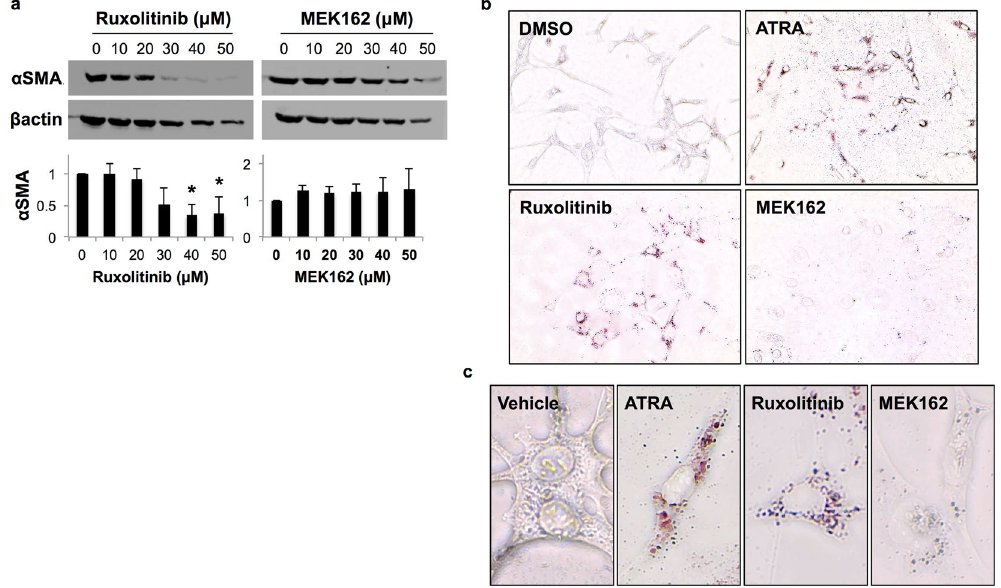
Figure 4. Jak/STAT inhibition reduces PSC activation in vitro . ( a ) Lysates of PaSC were taken after 72 hours of treatment with either ruxolitinib or MEK162. α -SMA expression was assessed by immunoblot and quantified by densitometric analysis. Graphs display mean ± SD of 3 biological replicates ( * indicates p < 0.05). (b,c) PaSC were stained with Oil-Red O to examine quiescence or pseudoquiescence following incubation with vehicle, 10 μ M ATRA (positive control), 10 μ M ruxolitinib, or 10 μ M MEK162 for 48 hours. (b) Light microscopy images were taken at 20X magnification. (c) Increased magnification of 20X images are shown below at